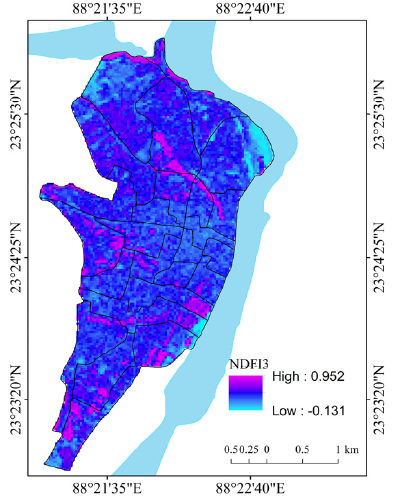
Figure 28. NDFI2 Figure 28. NDFI2 (2000).